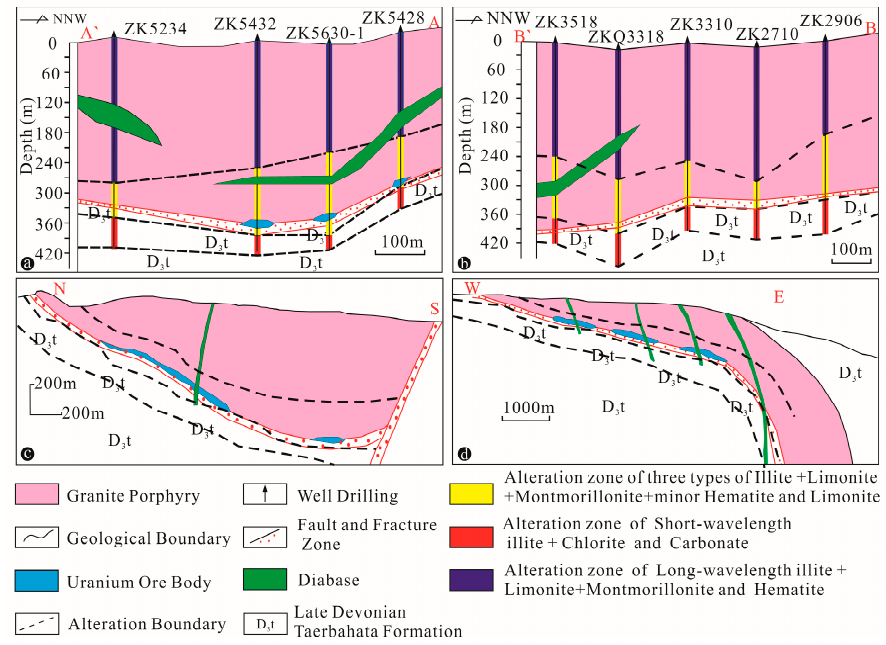
Figure 9. ( a ) Alteration zoning in cross section AA’. ( b ) Alteration zoning in cross section BB’. ( c ) Inferred alteration zoning of the cross sections in the N-S direction (modified from the Geological Team 216). ( d ) Inferred alteration zoning of the cross sections in the E-W direction (modified from the Geological Team